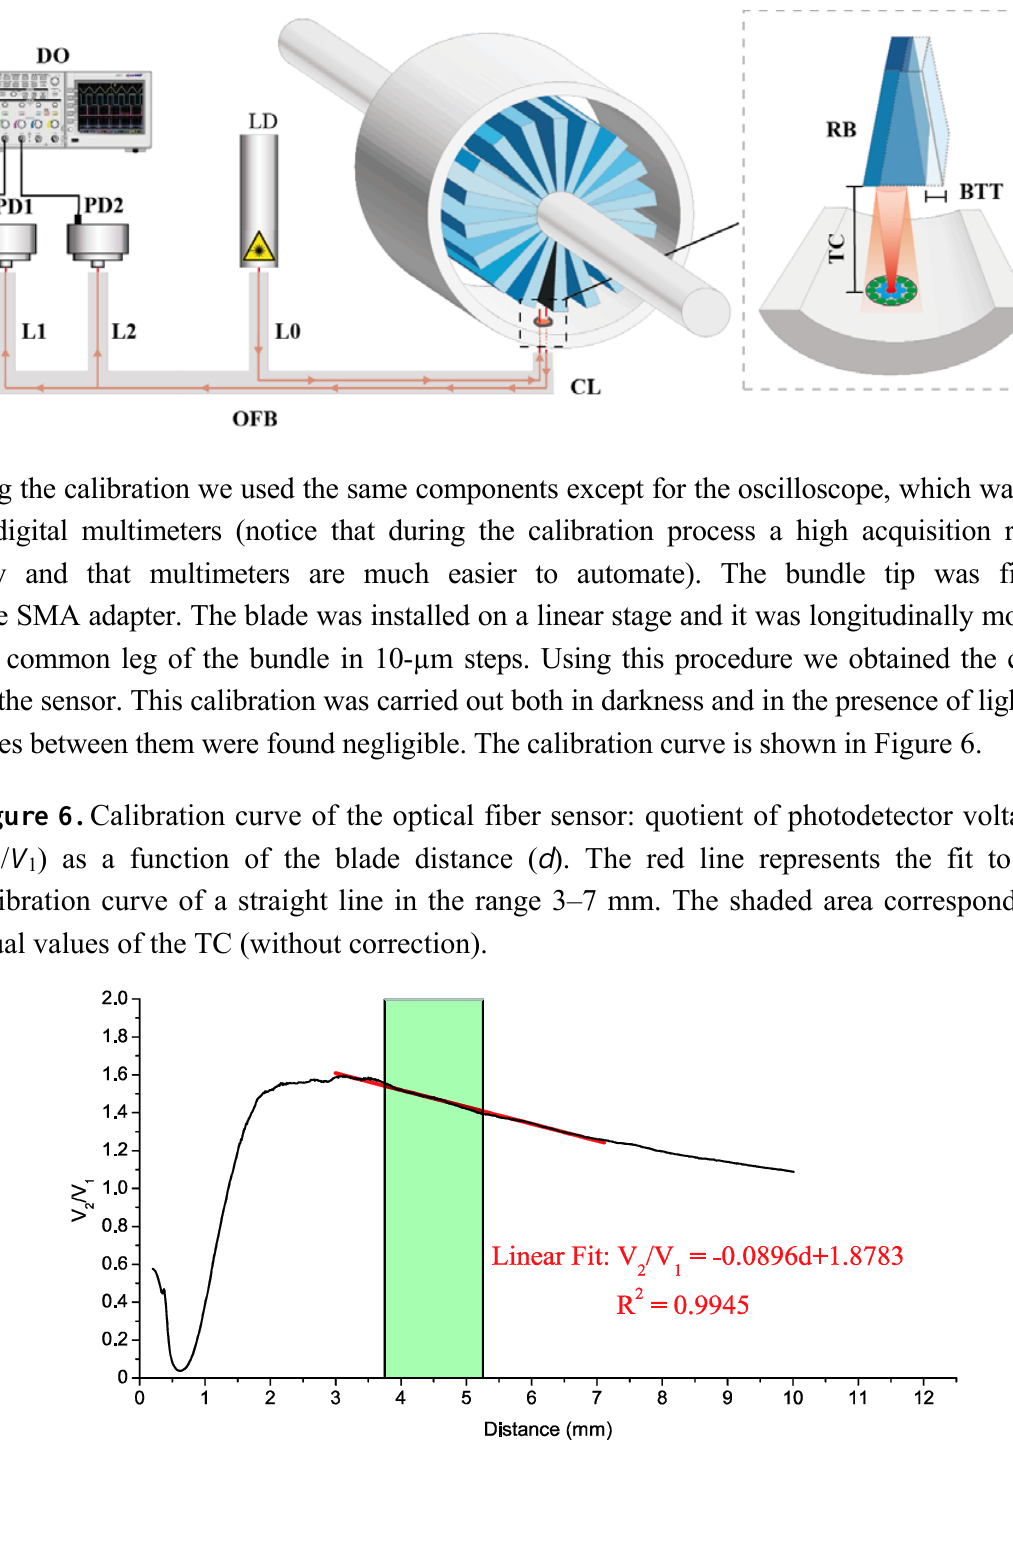
Figure 5. Experimental set-up and operational principle. Legend: DO: Digital Oscilloscope; PD1: Photodetector 1; PD2: Photodetector 2; OFB: Optical Fiber Bundle;